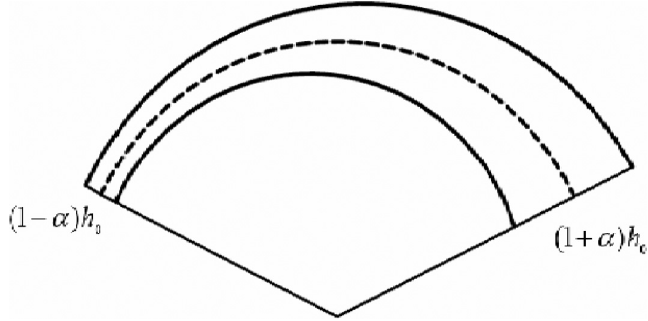
Fig. 10. Unsymmetric tapered arch with linearly varying height.